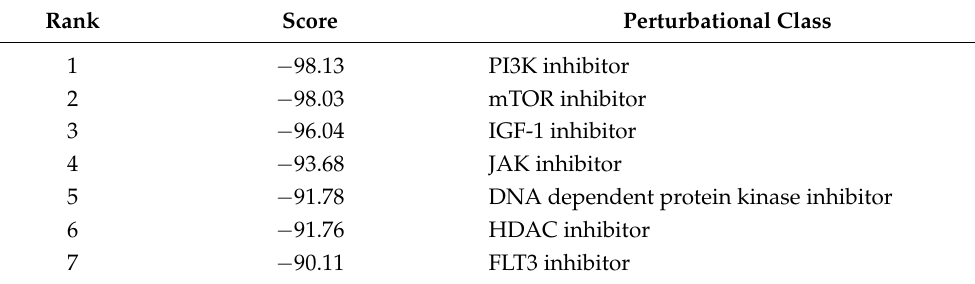
Table 2. Perturbagen class and hits with connectivity score of less than −